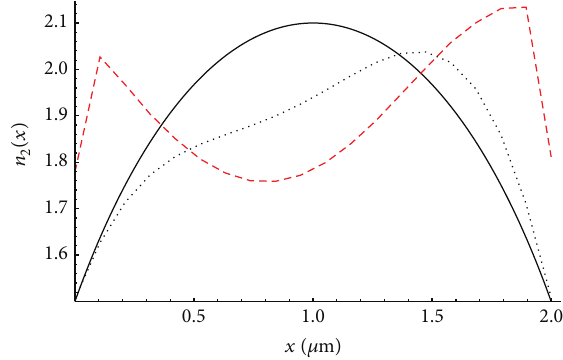
Figure 9: Reconstructed profiles for the case of perturbed data ( 𝛿 = 0.3 ). The solid curve corresponds to the initial profile 𝑛 dashed line corresponds to the reconstructed profile at 𝛼 = 0.2 , 𝛽 𝑖 = 5 , and the dotted line corresponds to 𝛼 = 𝛽